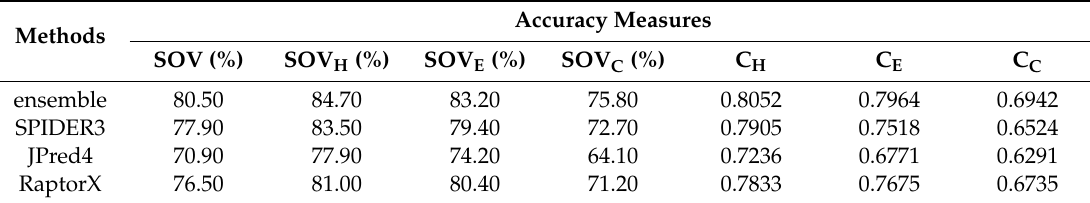
Table 3. SOV scores and MCC results by four di ff erent methods for 513 protein Cu ff & Barton set